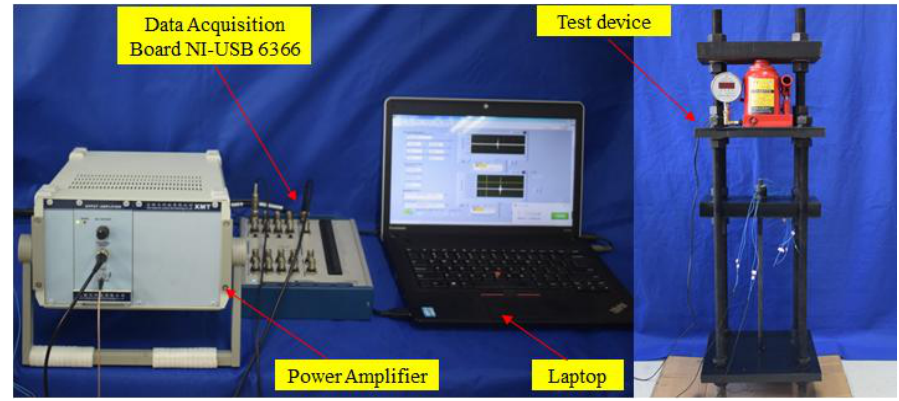
Figure 3. The experimental setup.